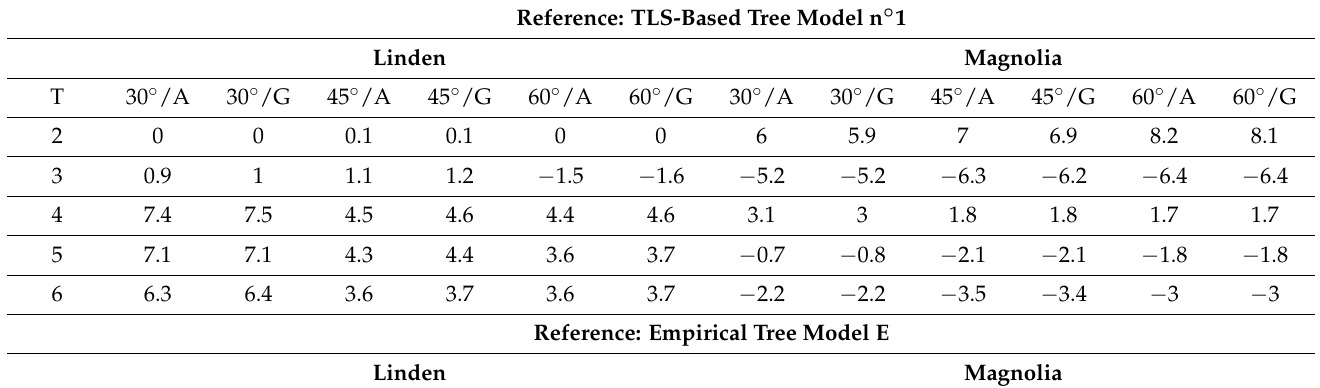
Table 4. Comparison of the mean spectral bias error B expressed in % between the two reference tree models and different geometric tree representations (first column: T stands for the number of the compared tree models) for 6 T c observations (SZA = 30/45/60 ◦ and BACKGROUND = A – asphalt / G – grass) and the two tree species. Table 1. This is a table caption. Tables should be placed in the main text near to the first time they are cited.